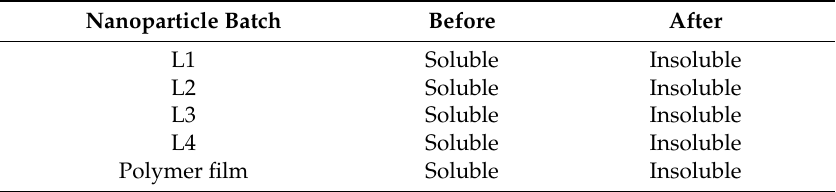
Table 5. Solubility of Uns-PHA nanoparticles in acetone, along with a corresponding thin film, before and after exposure to an incandescent yellow lamp. Two milliliters of nanoparticle samples (containing 6.6 mg of polymer) or the same amount of polymeric film were treated with 10 mL acetone; any lack of solubility was determined by a qualitative assay, registering the presence of turbidity (UV analysis at 500 nm) in native or irradiated samples.